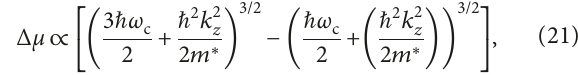
4 . 2K, λ 337 μ m, H (cid:29) ≈